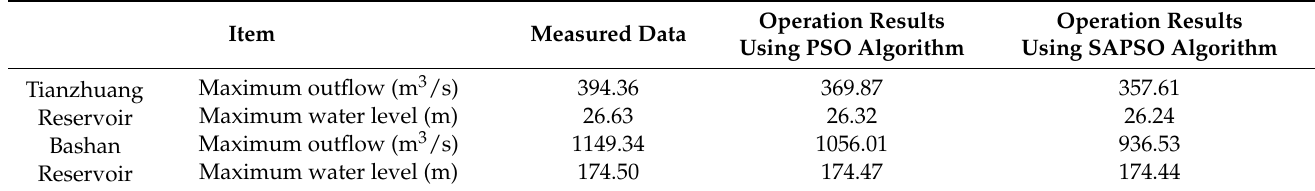
Figure 6. Operation hydrographs of Bashan Reservoir for the 13 August 1974 flood. Table 4. Comparison of operating results for the 31 July 1964 flood.